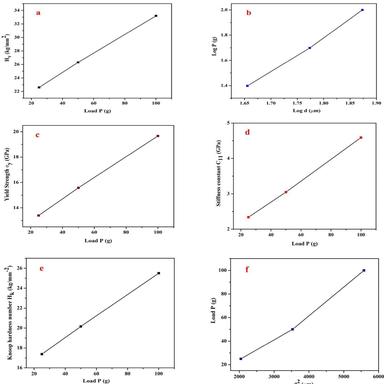
(a) Hardness value (b) Mayers plot (c) Yield strength (d) Stiffness constant (e) Knoop hardness and (f) plot log P vs. d2 .